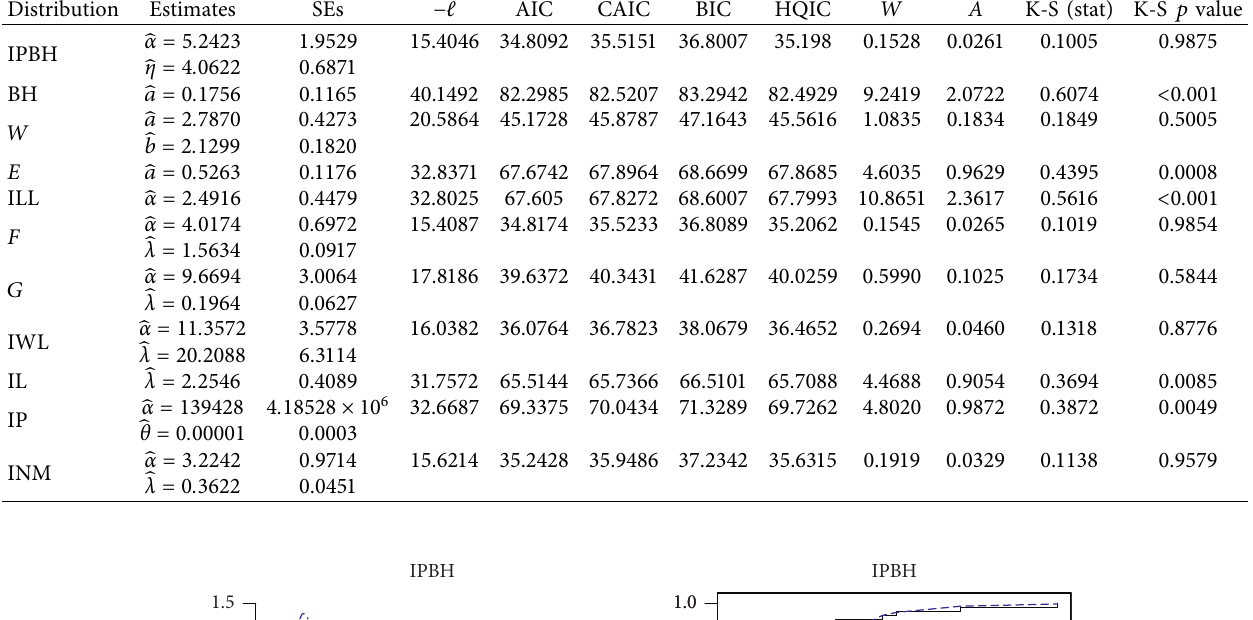
Table 7: The estimates of the parameters of the IPBH distribution and other competing models with several discrimination statistics for dataset II.